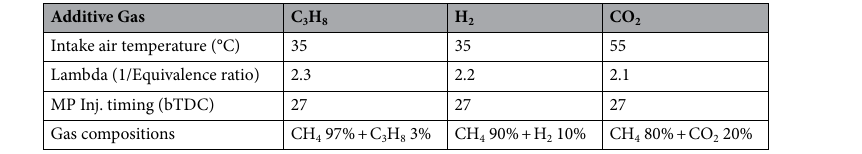
Table 4. Optimum engine operating conditions, obtained by adding various additive